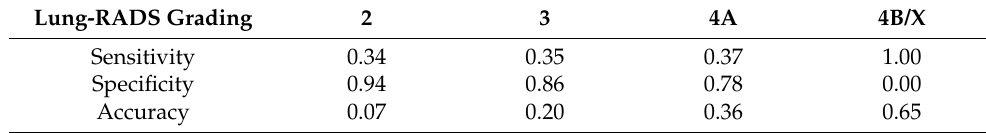
Table 8. Sensitivity, specificity, and accuracy of Lung-RADS 1-4B/X for diagnosing